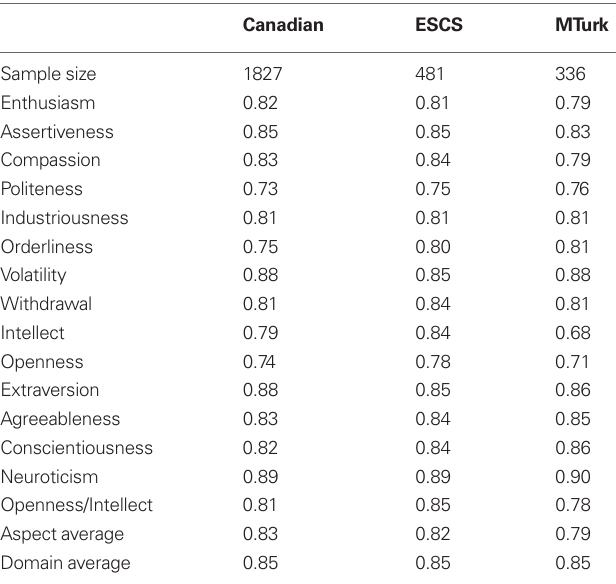
Table 1 | Alpha reliabilities for Big Five domains and aspect scales by